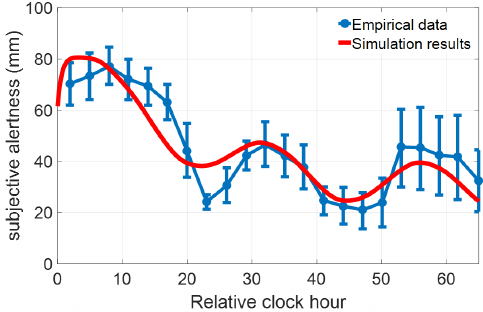
Figure 4. Comparison of predicted alertness from simulation results of the 60 h constant routine protocol with the subjective alertness data (mean ± SD) in [26]. The initial point 0 in the relative clock hour is referred to as the wake time. The predicted alertness A ( t ) in the three-process model has been scaled to fit the empirical